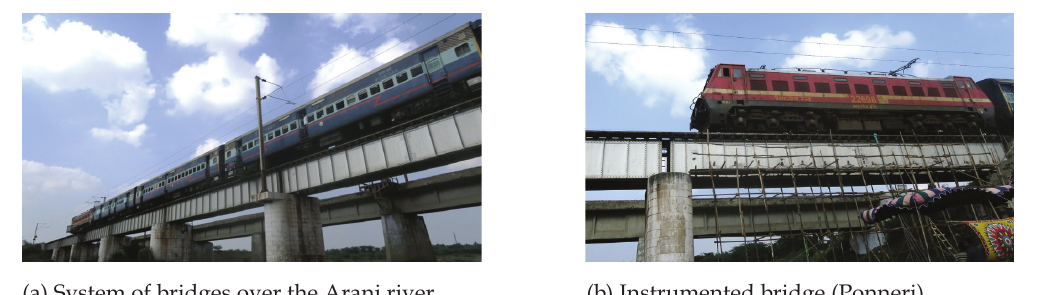
Figure 2. ( a ) System of railway-bridges over the Arani river in Chennai; and ( b ) instrumented bridge evaluated in this section, which is called Ponneri